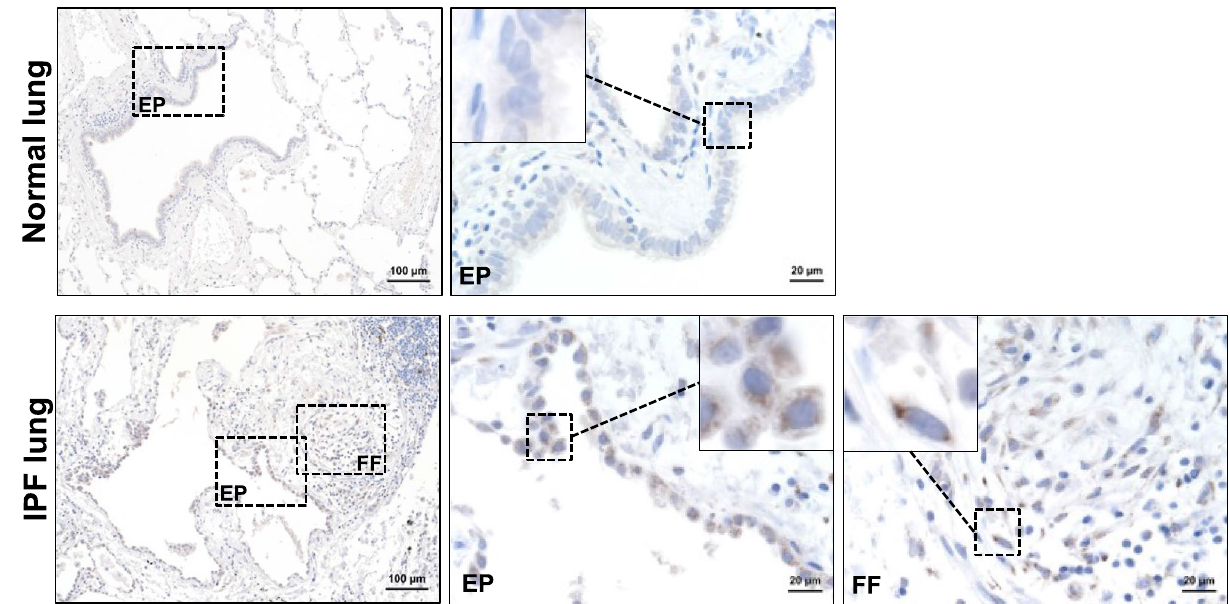
Figure 1. BMP1 expression is increased in human IPF lungs. Representative images of BMP1 immunochemistry staining in human IPF and normal lung specimens. EP epithelial cells, FF fibroblastic